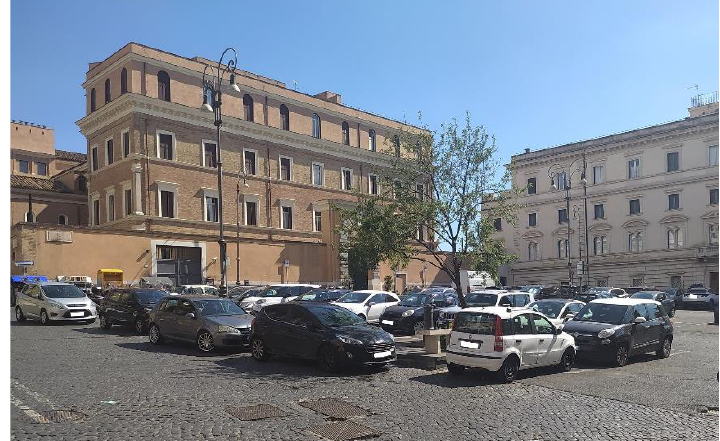
Figure 1. St. Peter in Chains’ square, Rome, Italy.